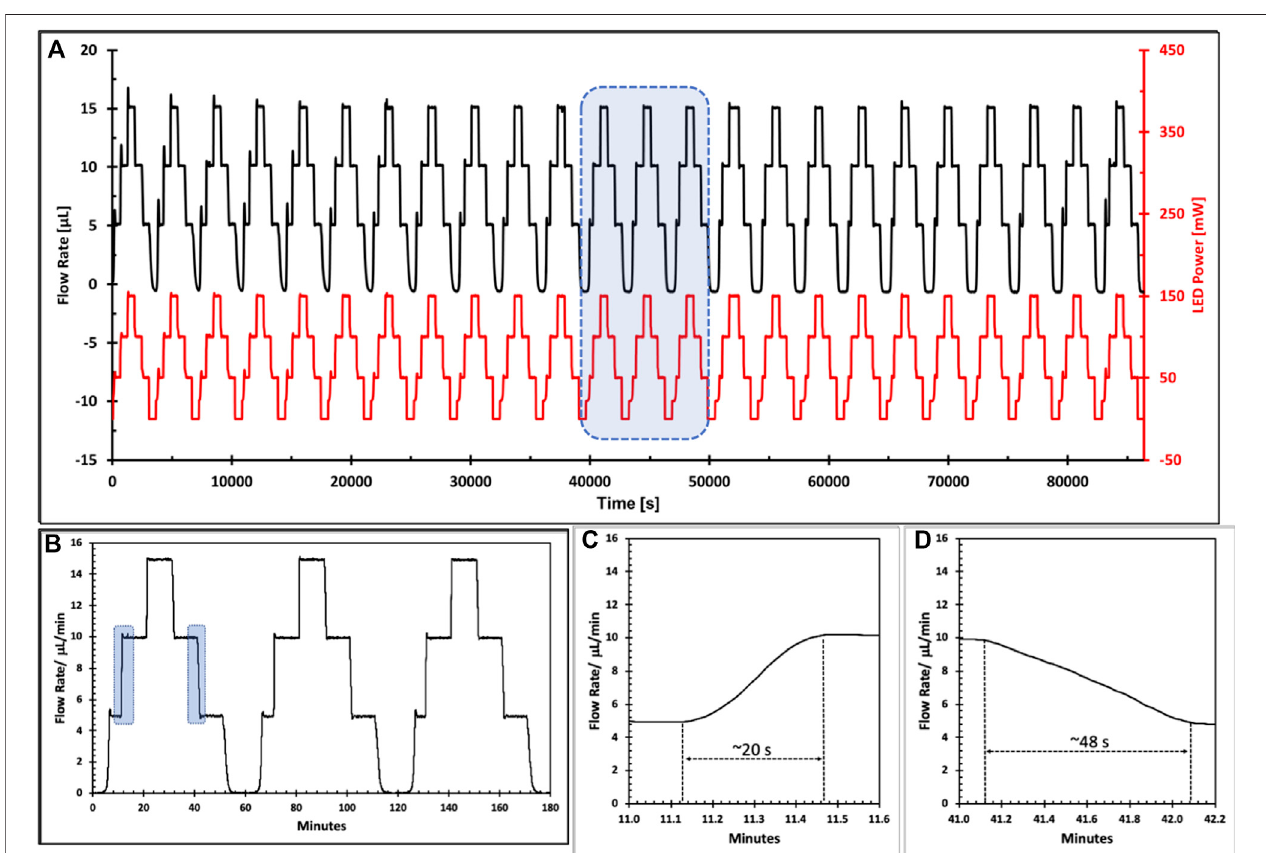
FIGURE 7 | (A) 24 h Continuous Flow Control with a soft polymer valve showing excellent reproducibility over multiple fl ow rate switching of the sequence 0 → 5 → 10 → 15 → 10 → 5 → 0 μ L/min(black).TheassociatedLEDpowerswitchingpatterntogeneratethis fl owratecontrolisshowninred; (B) Zoominonthehighlighted section of (A) showing detail of three complete fl ow rate switching sequences illustrating accuracy of the switching between set fl ow rates and stability of set fl ow rates. (C,D) Indication of the speed of switching between fl ow rates focusing on the illustrated sections of the fi rst pattern in (B) . Increasing fl ow rate 5 → 10 μ L/min is associated with a contraction of the gel valve and is completed in ca. 20 s; decreasing fl ow rate 10 → 5 μ L/min is associated with an expansion of the gel valve and is slower at ca. 48 s.